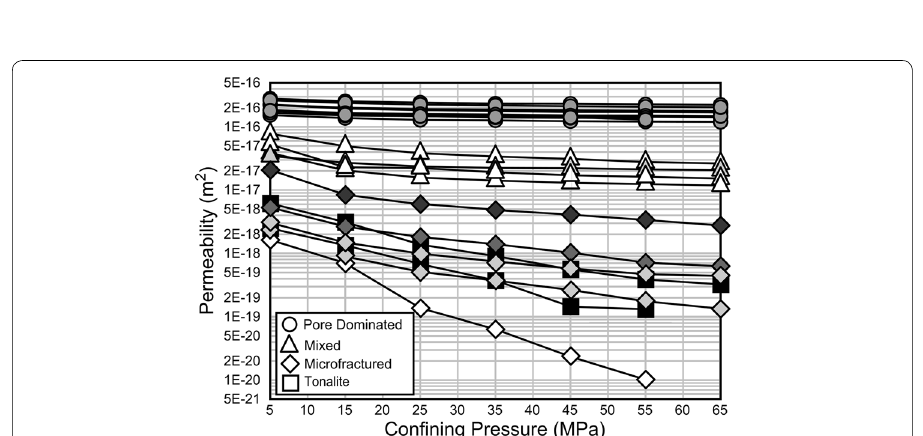
Fig. 10 Permeability versus confining pressure. Tone darkens with depth of sample, as shown in legend in Fig.